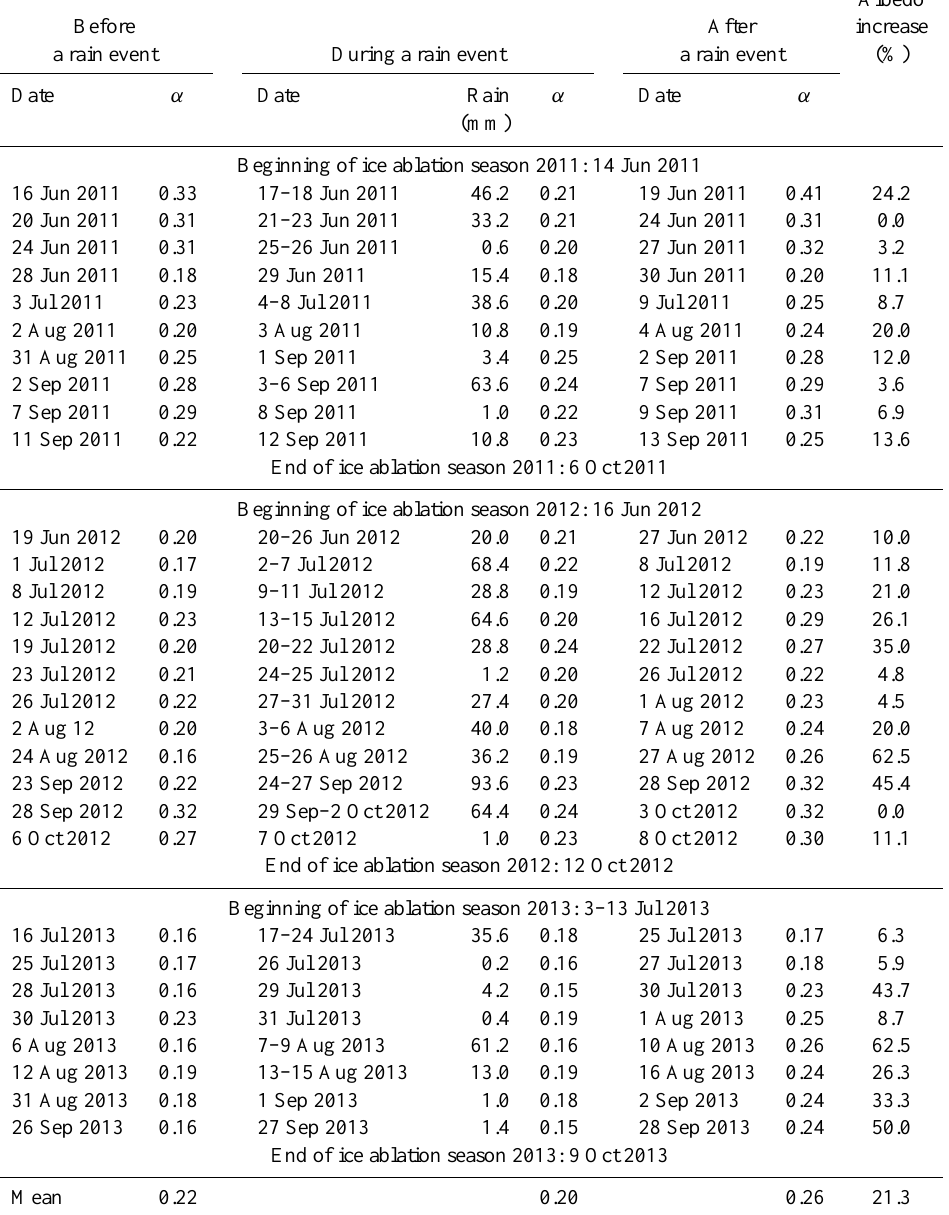
Table 1. Influence of rainfall on ice albedo ( α ) measured from the AWS1 Forni. In the table the 30 rain events (and relative rain amount) that occurred during the 2011, 2012 and 2013 ablation seasons, and the albedo values before, during and after every rainfall are reported. Albedo Before After increase a rain event During a rain event a rain event (%) Date α